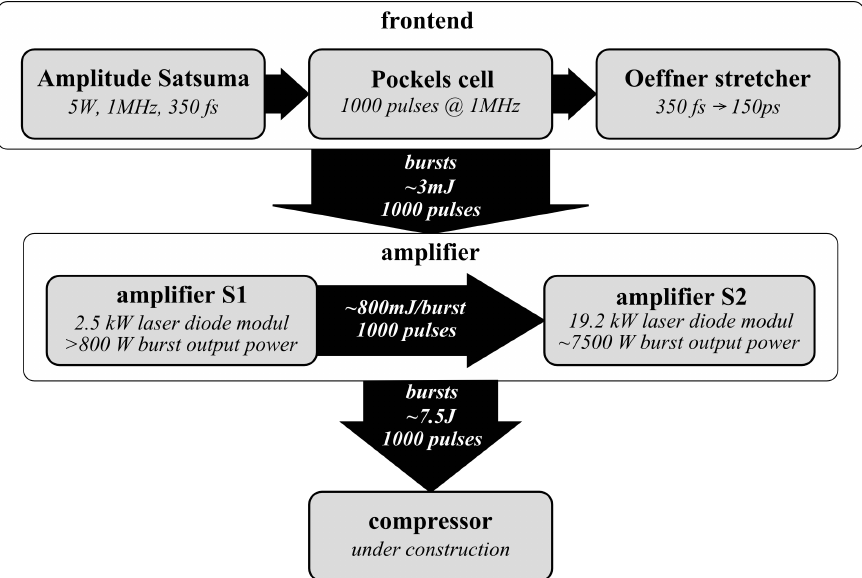
Figure 1. Basic layout of the laser